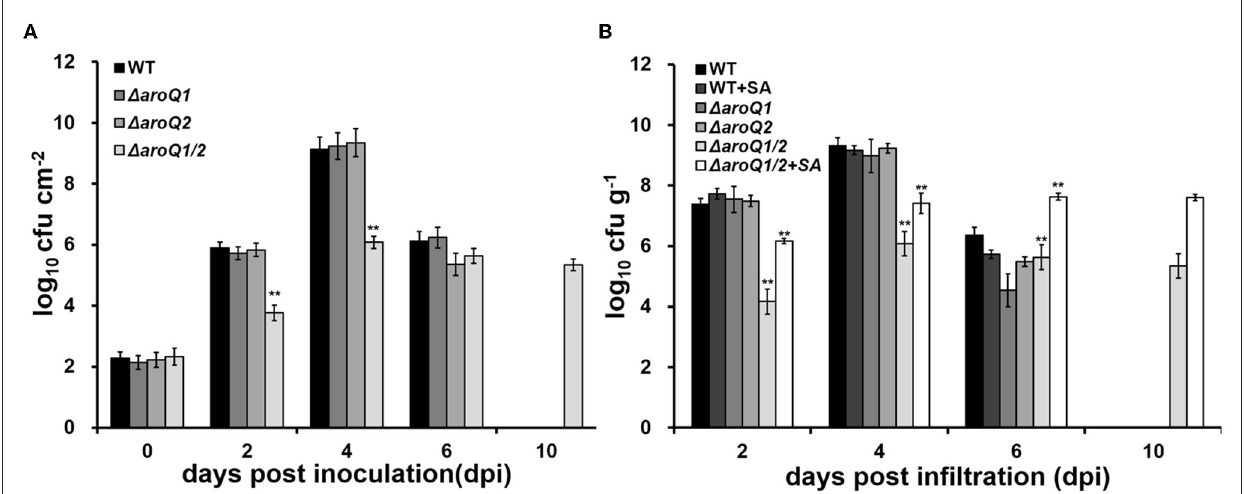
FIGURE2 Involvement of AroQ on the growth of R. solanacearum OE1-1 in (A) tobacco leaves (intercellular spaces) and (B) tomato stems (xylem vessels). WT, RK5050 (OE1-1, popA-lacZYA ); 1 aroQ1 , RQ5920 (RK5050, 1 aroQ1 ); 1 aroQ2 , RQ5908 (RK5050, 1 aroQ2 ); 1 aroQ1/2 , and RQ5951 (RK5050, 1 aroQ1/2 ); + SA, with supplementary shikimic acid (SA). For growth in tobacco leaves, which was presented in log CFU cm − 2 , cell suspension of 0.1 OD 600 was infiltrated into tobacco leaves, and leaf disks (0.38 cm 2 ) were punched for the quantification of cell number by the dilution plating. For the growth assay in tomato stems, which was presented in log CFU g − 1 , tomato plants were inoculated with the petiole-cutting inoculation method, and stem species were cut and weighted for the quantification of cell number by dilution plating. For SA supplementation, shikimic acid was added into a one-quarter diluted minimal medium at 300 Mm, tomato cutting seedlings were soaked for 4 days, and then were inoculated with the petiole-cutting inoculation method. Each assay was repeated with three biological replicates including three replicates per trial for the in vitro growth assay, and more than four biological replicates with six plants per trial for the in planta growth assay. Mean values from all experiments were averaged and presented with SD, and statistical significance between the double mutant and RK5050 was assessed using a post-hoc Dunnett’s test following ANOVA. Significance level, ** indicates P <